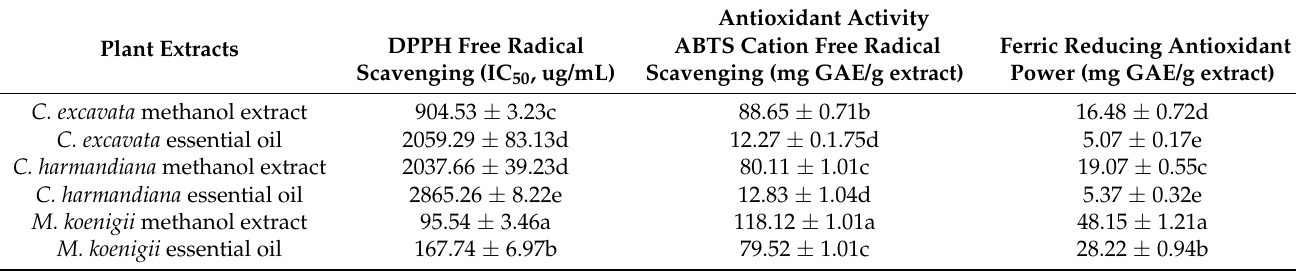
Table 3. Antioxidant activity of methanol extract and essential oil of Clausena excavata , Clausena harmandiana and Mur- raya koenigii